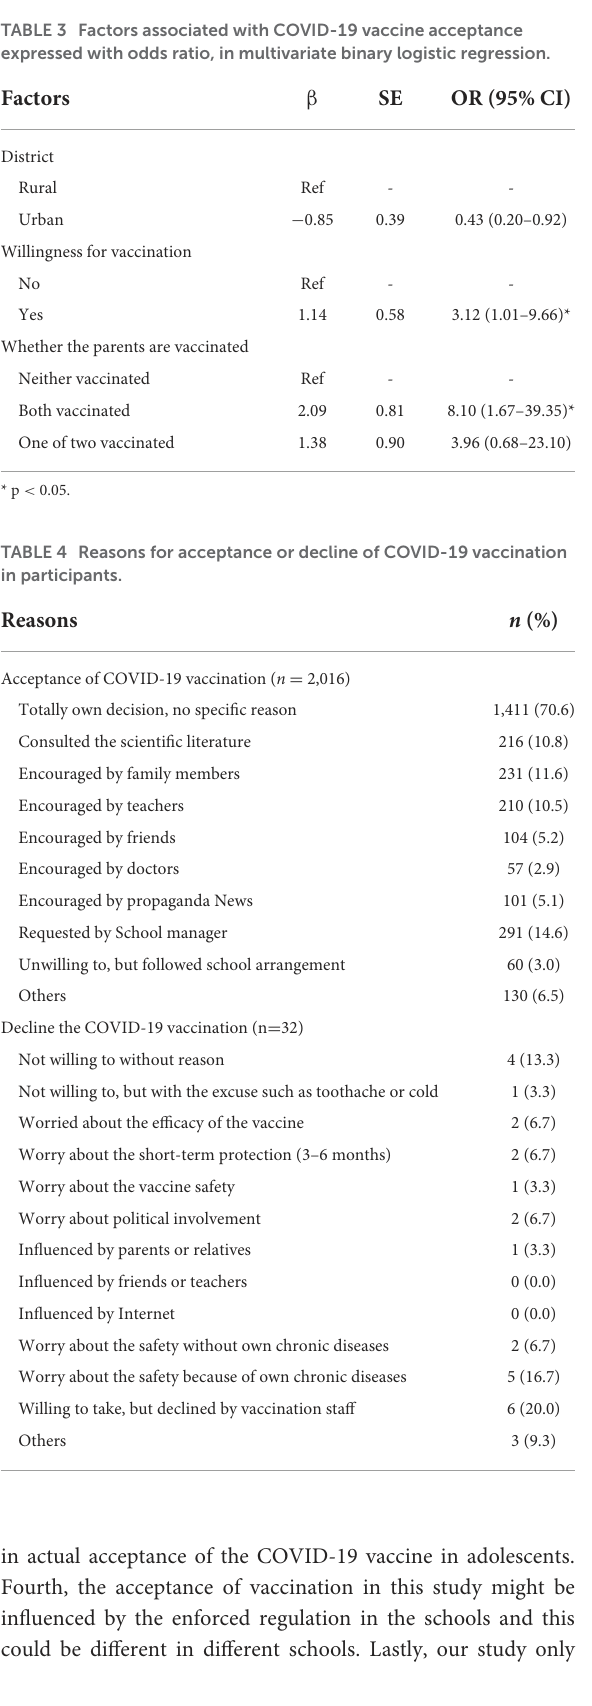
TABLE 5 Self-reported Adverse events in vaccinated participants.